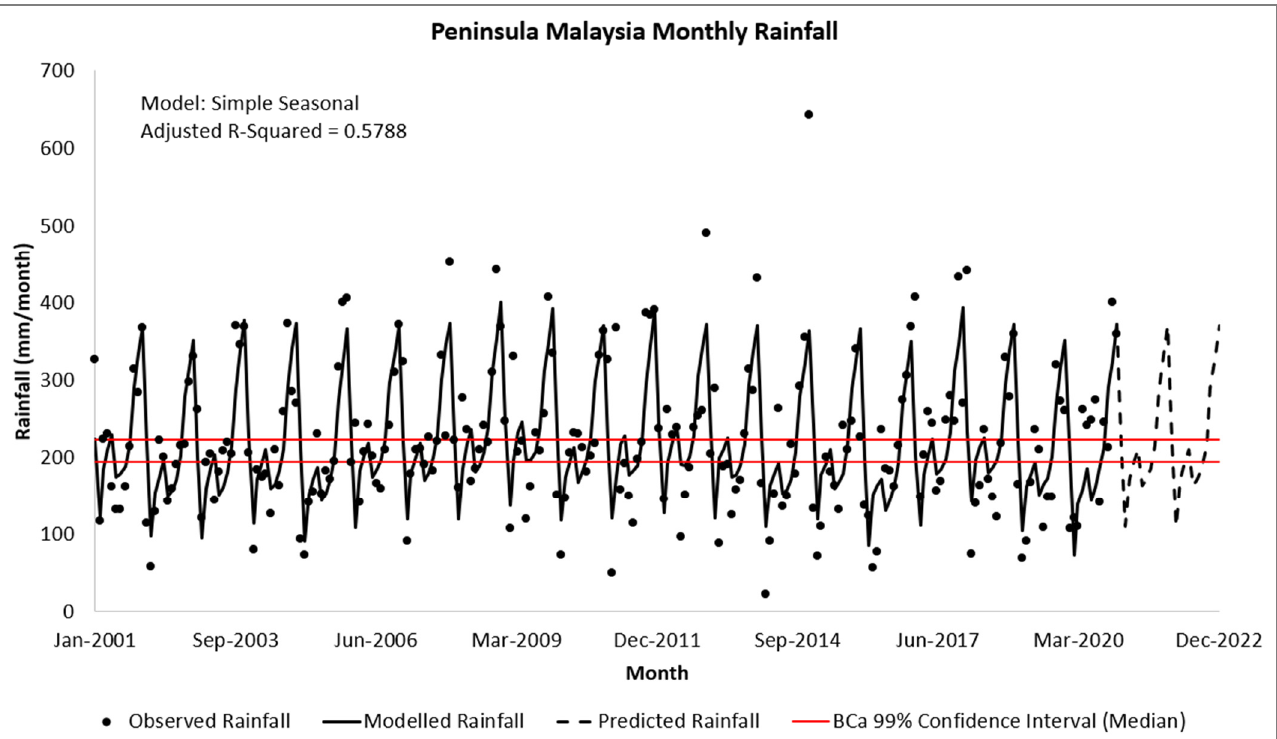
Figure 11. Monthly rainfall time series forecasting model for Peninsula Malaysia using Expert Modeler. Modelled period: 2001–2020 (N = 240, see Appendix A). Forecasted period: 2021–2022 (N = 24).